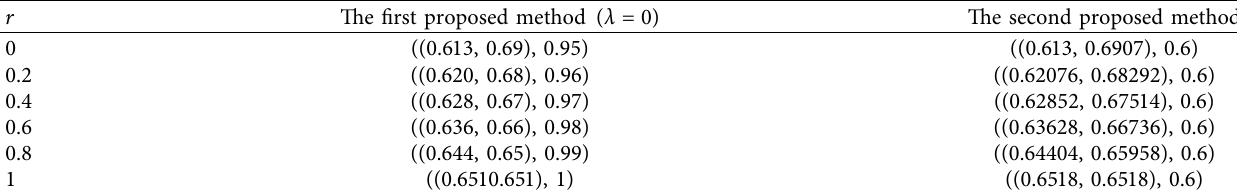
( r ) result using the two proposed methods ( λ � 0 ) . 2